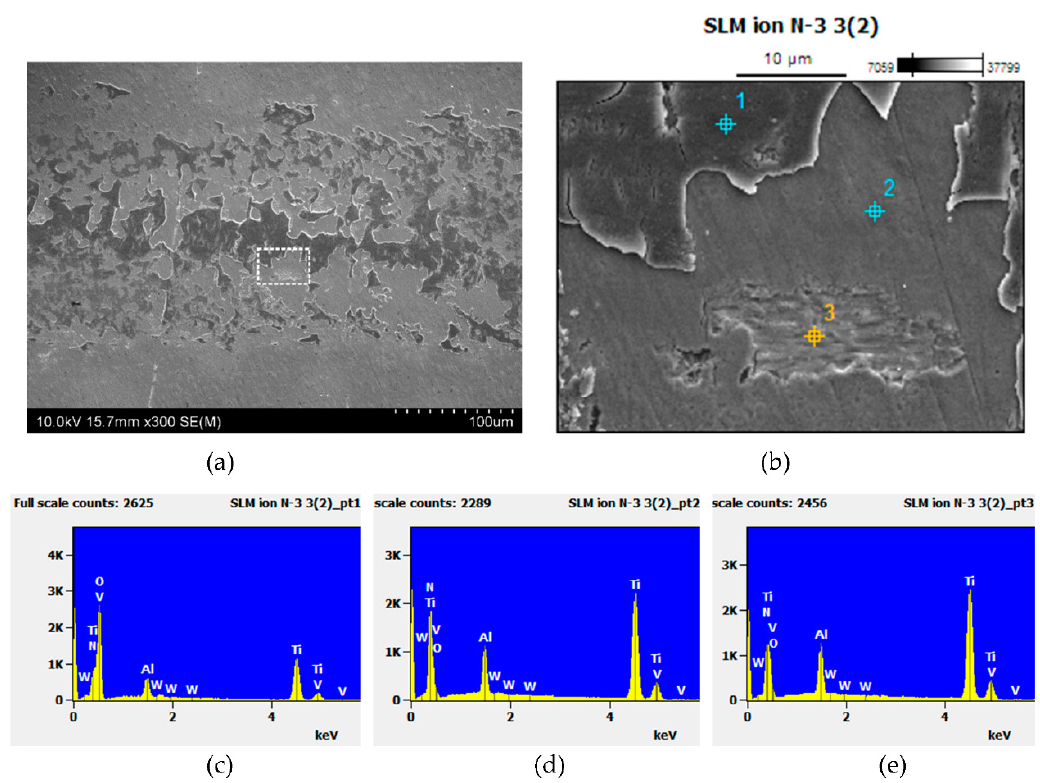
Figure 5. SEM images ( a , b ) in higher magnifications taken in SLM-N1 track from the second test and EDS spectra in locations of ( c ) point 1, ( d ) point 2, and ( e ) point 3 as indicated in ( b ).